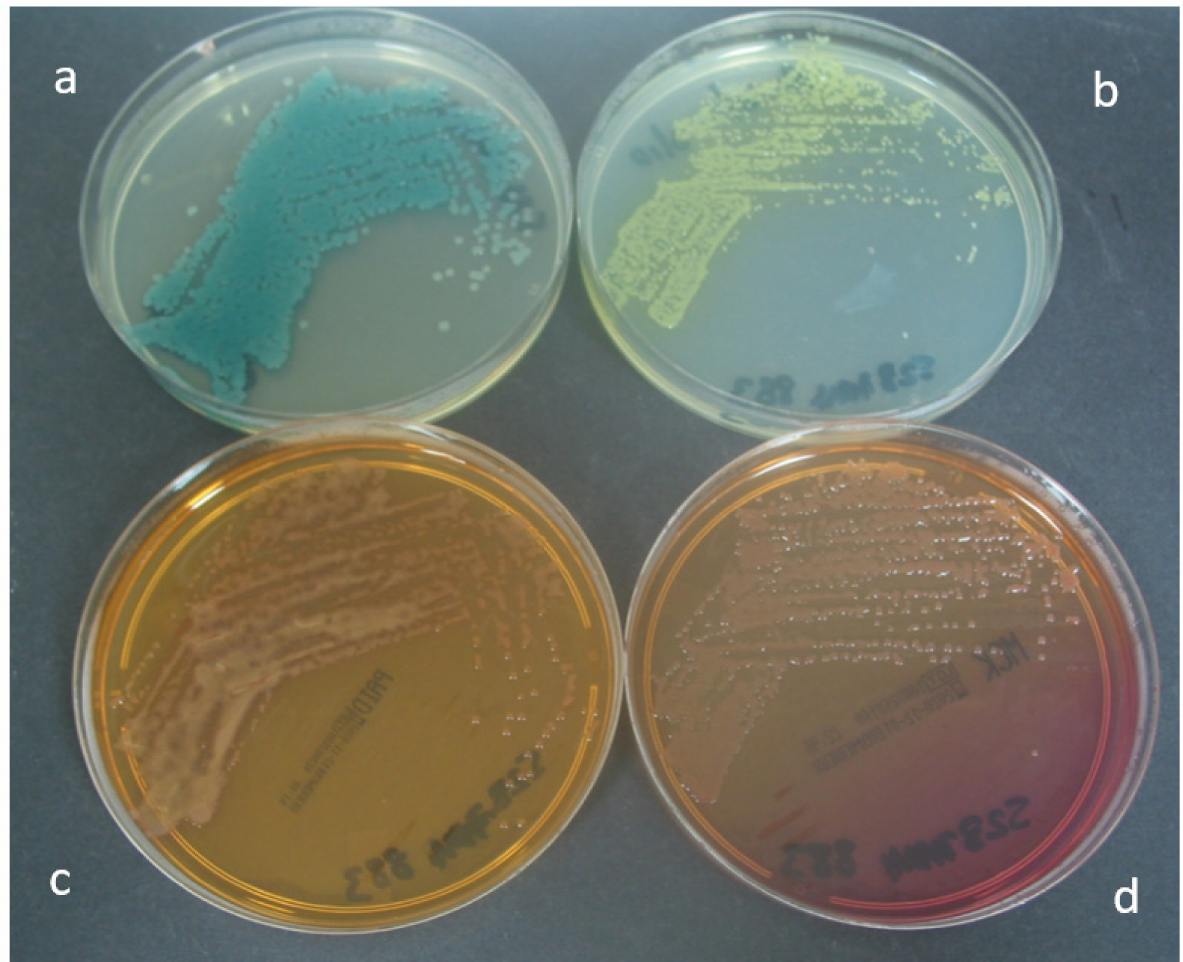
Figure 3. Appearance of P. aeruginosa after 24 h incubation on ( a ) CHROMagar™ Pseudomonas,